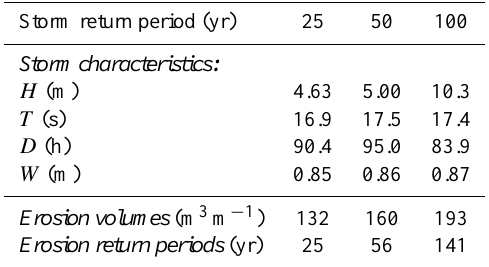
Table 3. The storm parameters associated with the multivariate re- turn periods 25, 50 and 100yr and the associated erosion return pe- riods calculated by incorporating a multiple linear regression with the most-likely design